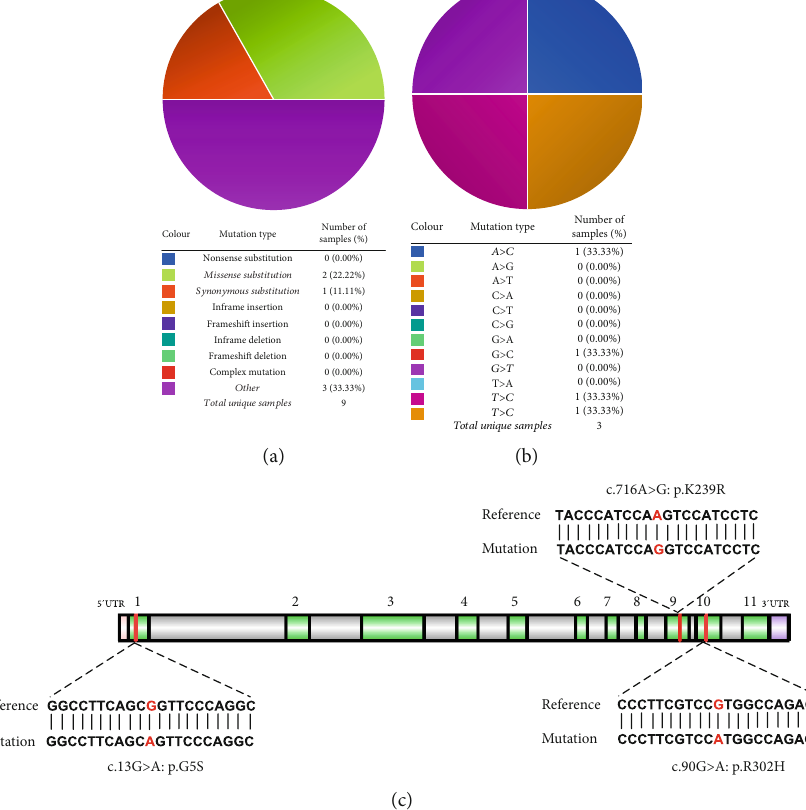
Figure 1: Genetic mutations in galectin-9: (a) an overview of the mutations in galectin-9 in the samples from patients with haematopoietic and lymphoid malignancies, according to the COSMIC database. (b) The substitution mutations of galectin-9 in the haematopoietic and lymphoid cancer samples, according to the COSMIC database. (c) Schematic representation of galectin-9, indicating the location of the mutations identi fi ed by targeted deep sequencing in patients with di ff use large B cell lymphoma